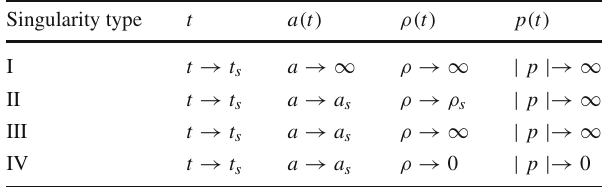
Table 3 The possible finite time future singularities for an FRW cos- mology Singularity